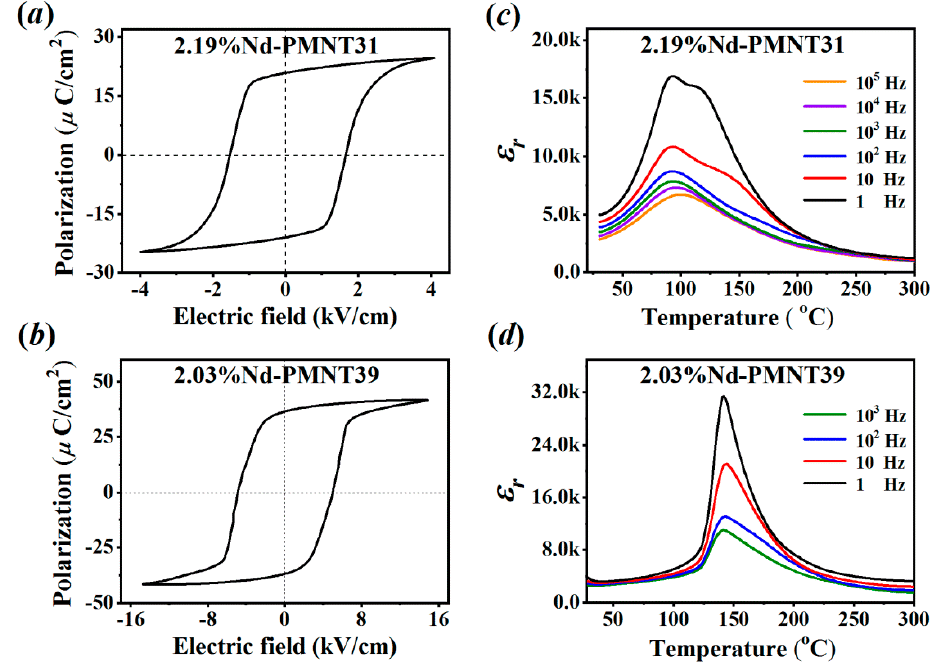
Figure 1. The polarization–electric field ( P - E ) hysteresis loops and the temperature dependence of dielectric constant ε r for ( a , c ) 2.19%Nd-PMNT31 and ( b , d ) 2.03%Nd-PMNT39 single crystals.